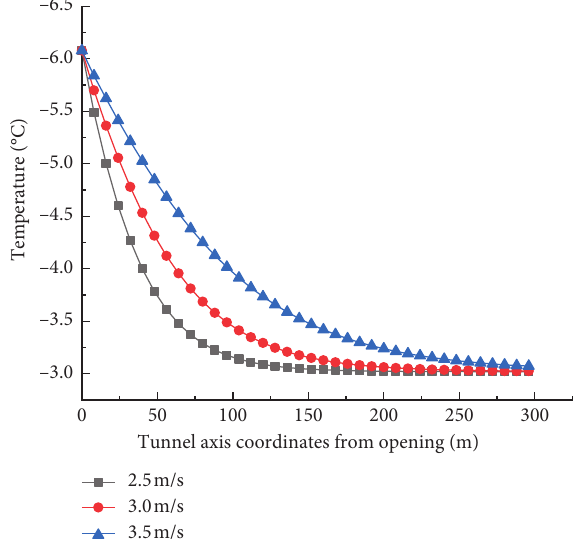
Figure 32: Distribution characteristics of the annual average air temperature in the tunnel axis under different air velocities.